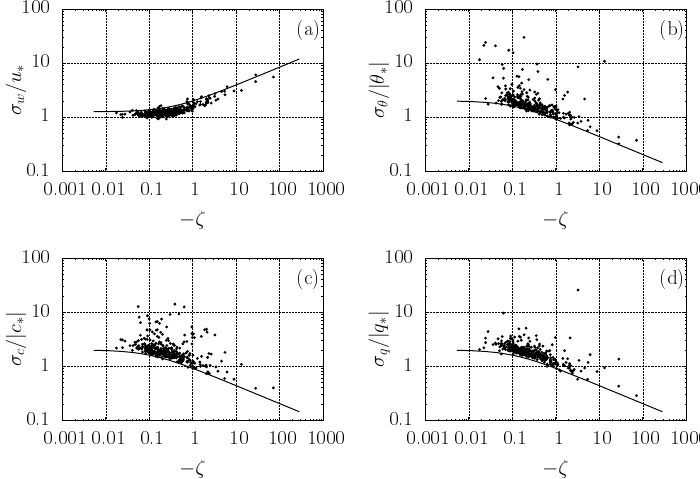
Figure 4. Dimensionless standard deviation for vertical velocity (a) , temperature (b) , CO 2 (c) , and water vapor (d) : 39.4m.